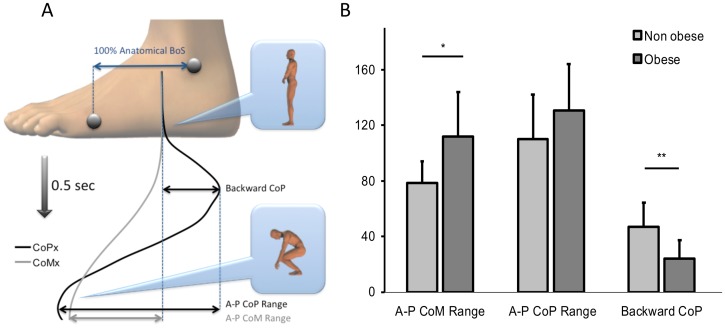
Mechanical equilibrium pattern.A typical pattern for a non obese participant modeled by the horizontal mobility of CoP and CoM into the BoS during the descending movement (a). A-P CoP and CoM range displacement, as a percentage of the anatomical distance from the BoS for the entire (descending + ascending) movement (b).